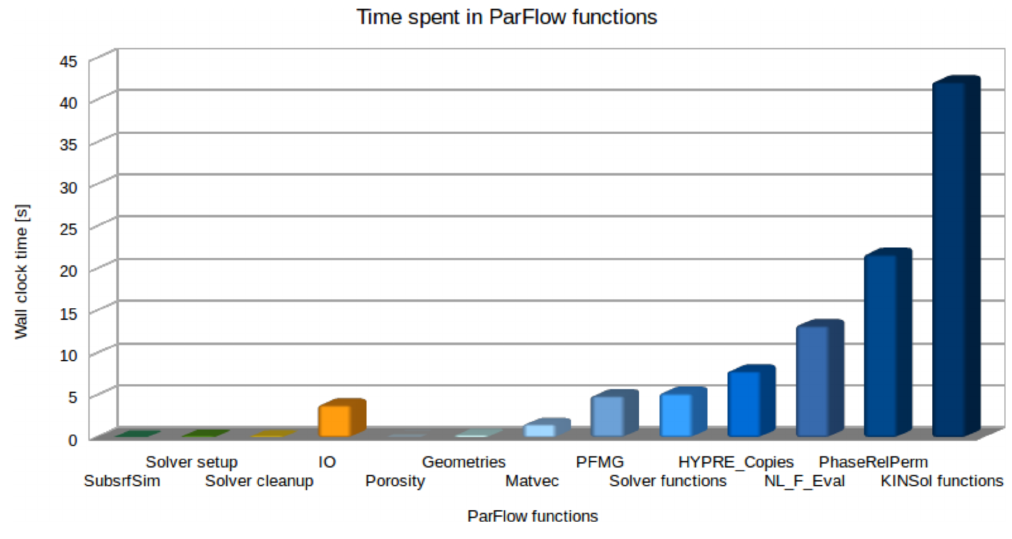
Figure 5. Time spent in ParFlow functions or routines, where the functions or routines can be divided into four categories: setup, cleanup, I/O, and solve. The functions in the category “setup” are depicted in green: SubsrfSim – setting up the domain; Solver setup – initializing the solver. The functions in the category “cleanup” are depicted in yellow: Solver cleanup – finalizing the solver. The functions in the category “I/O” are depicted in orange: PFB I/O – ParFlow binary I/O. The functions in the category “solve” are depicted in blue: Porosity – calculation of the porosity matrix; Geometries – calculation of the simulation domain; MatVec – matrix and vector operations; PFMG – geometric multigrid preconditioner from HYPRE, Solver functions – miscellaneous functions; HYPRE_Copies – copying data within HYPRE; NL_F_Eval – setting up the physics and field variables for the next iteration; PhaseRelPerm – setting up the permeability matrix; KINSol functions – nonlinear solver functions from SUNDIALS.